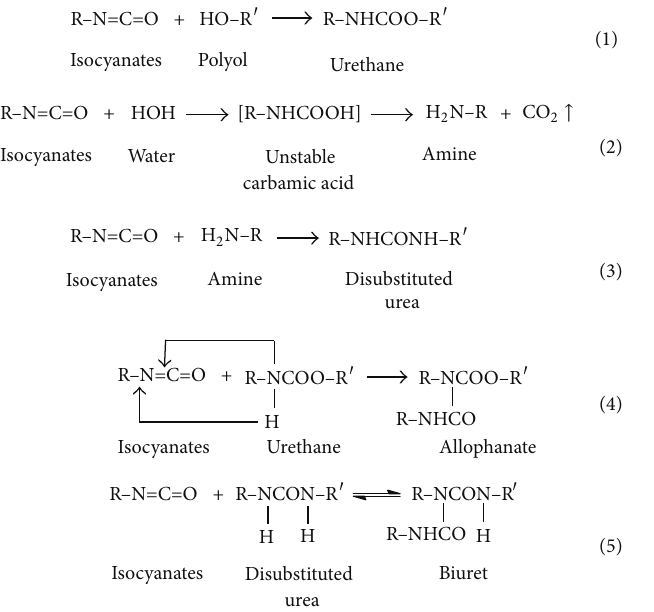
Figure 5: Schematic diagram for the reactions of isocyanates with (1) polyol, (2) water, (3) amine, (4) urethane, and (5) disubstituted urea in the synthesis of polyurethane. Source: Ionescu